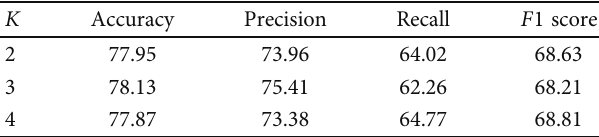
Table 6: Measures according to K .